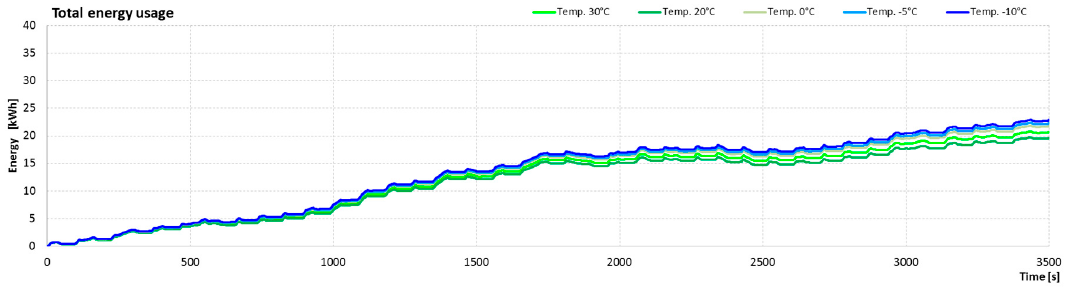
Figure 28. Results of simulation tests for the Gdynia-Flat route during changes the ambient temperature.